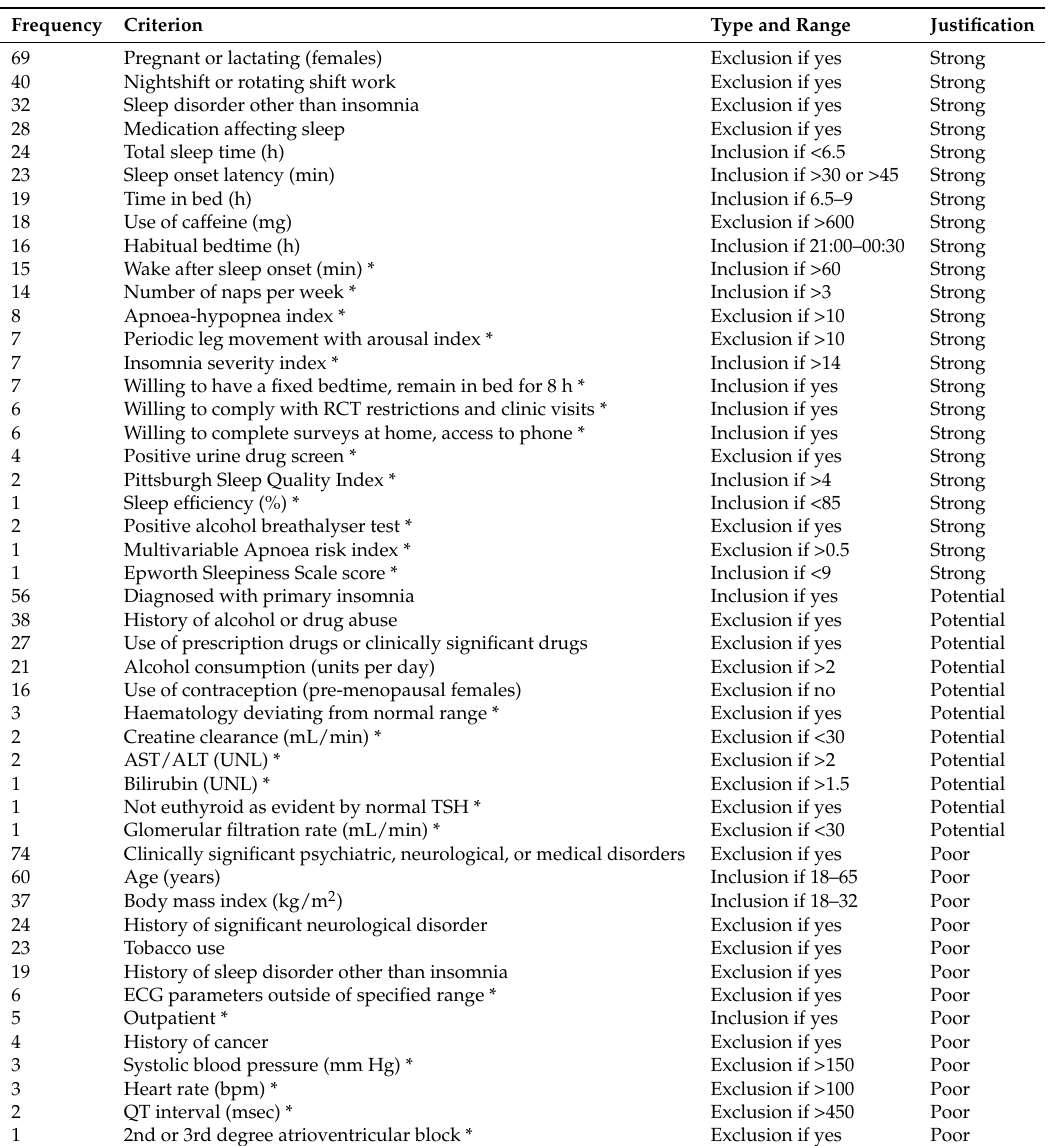
Table 1. Inclusion and exclusion